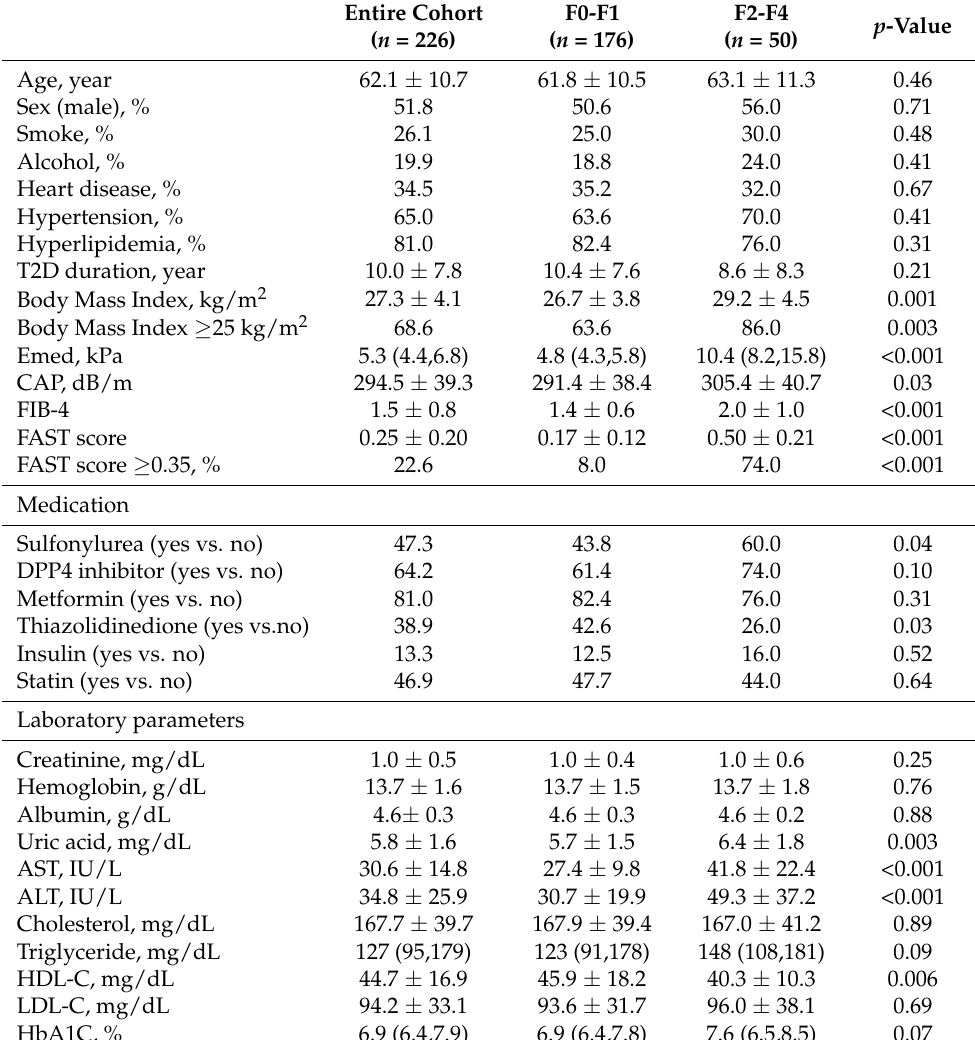
Table 1. The characteristics of study